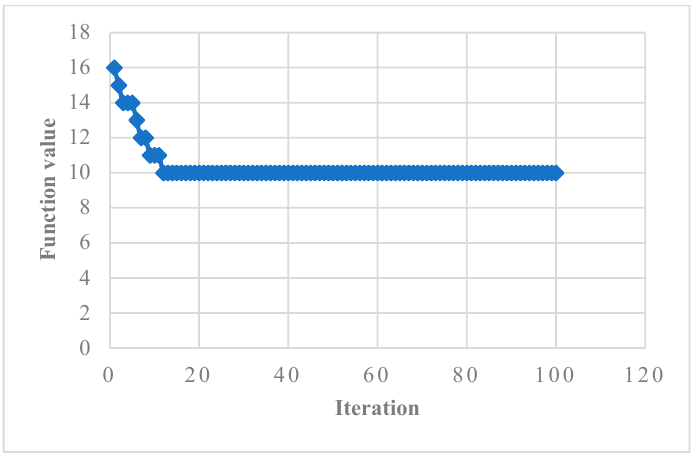
Table 1. Simulation results for different values of α .